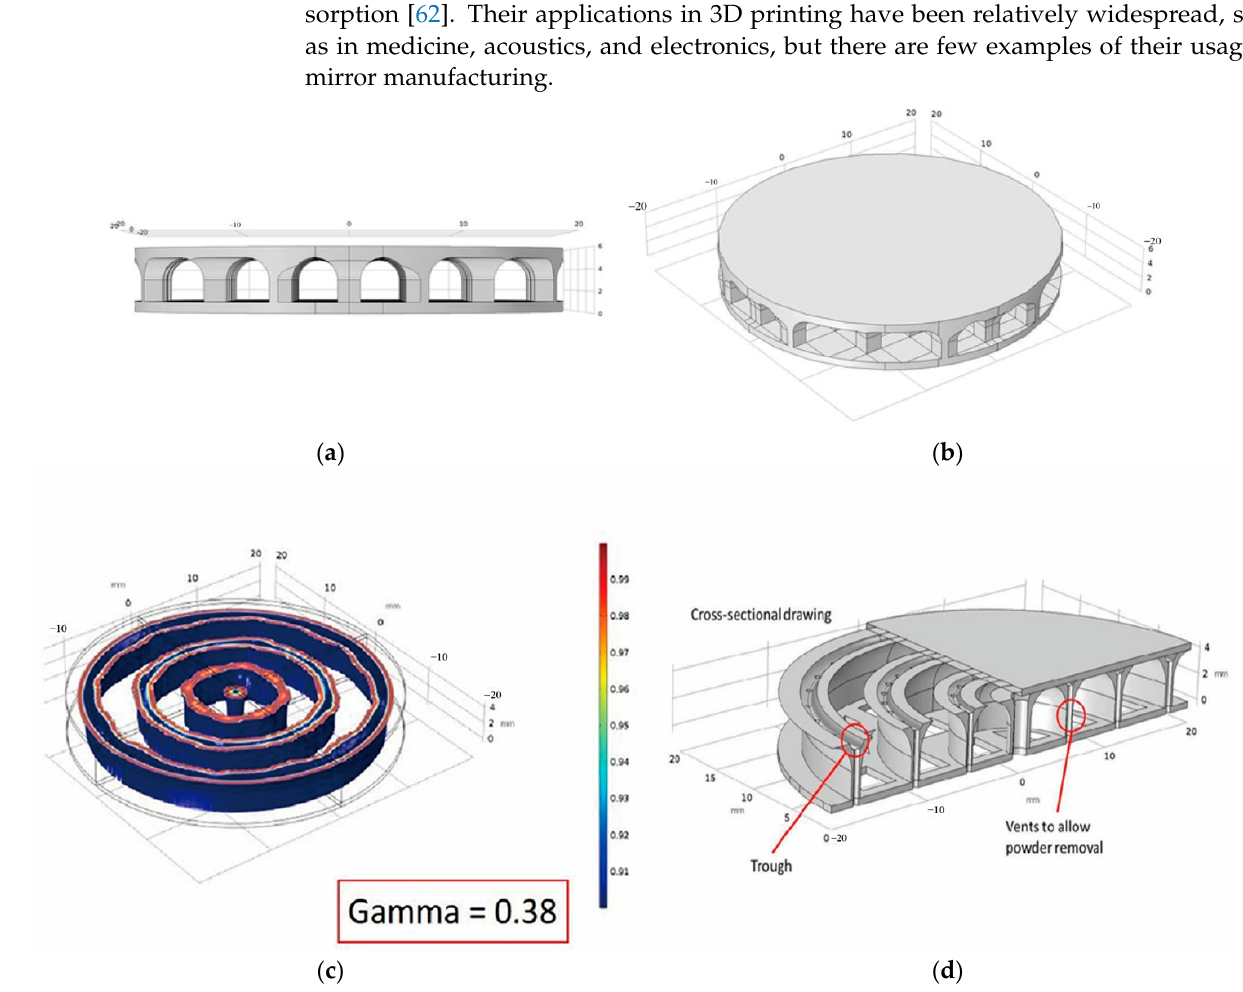
Figure 21. ( a , b ) Schematic of the initial sample [35]; ( c ) 38% of mass remaining − complete ring structure; ( d ) Preliminary optimized lightweight design for the sample [36].